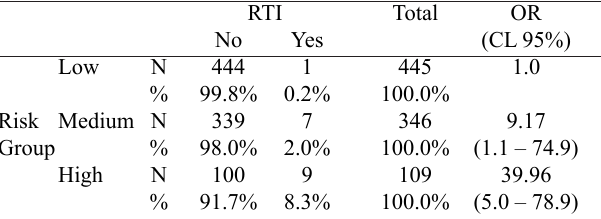
Table 7. Crossing of EuroSCORE and DDRF.